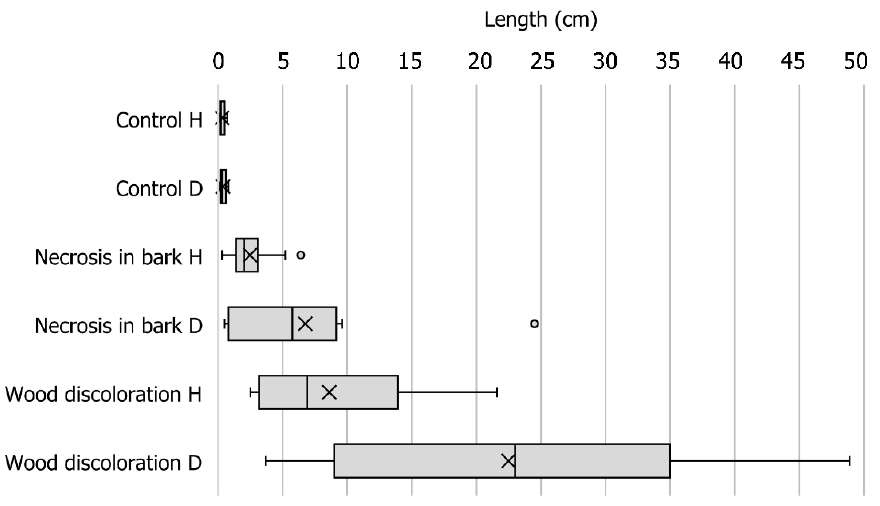
Figure 6. Boxplots showing necrosis and wood discoloration lengths of two-year-old Acer pseudoplatanus saplings inoculated with Cryptostroma corticale isolate ZLVG 859 after 38 days at 25 °C under two watering treatments (H—humid, D—drought). The boxplot shows the minimum, first quartile, median, third quartile, and maximum values; × designates average length; and the dots show outlier points.